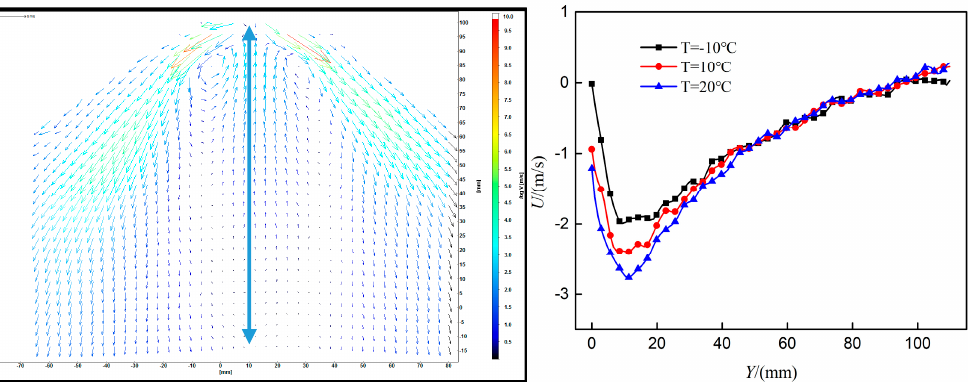
Figure 9. The influence of fuel temperature on the axial velocity ( U ) at the axis (Case A).